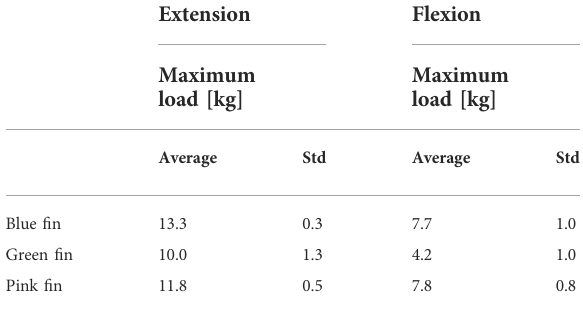
TABLE2Averagemaximumloadathighvelocitiesforboth fl exionand